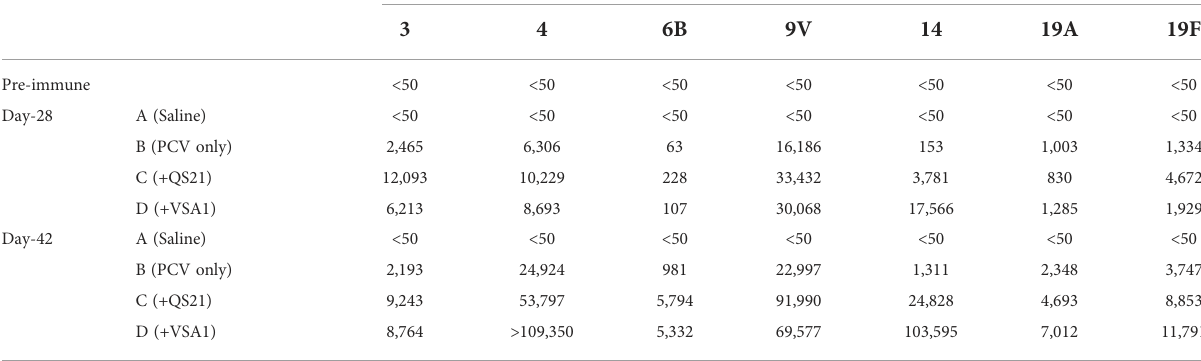
TABLE 1 ELISA Titer to Different Vaccine Serotypes a .